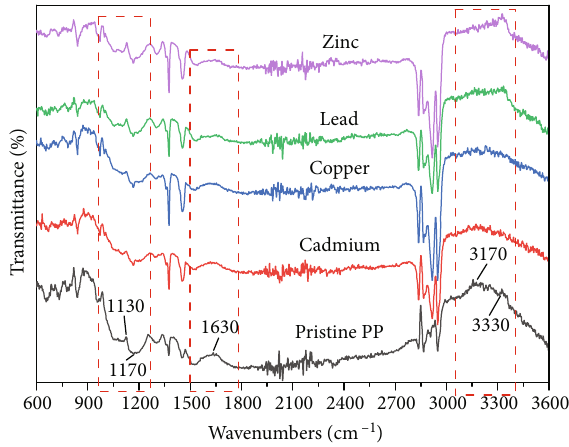
Figure 10: FTIR diagram of PP after adsorption of di ff erent kinds of heavy metals ( V = 20 mL, temperature at 298K, t = 48